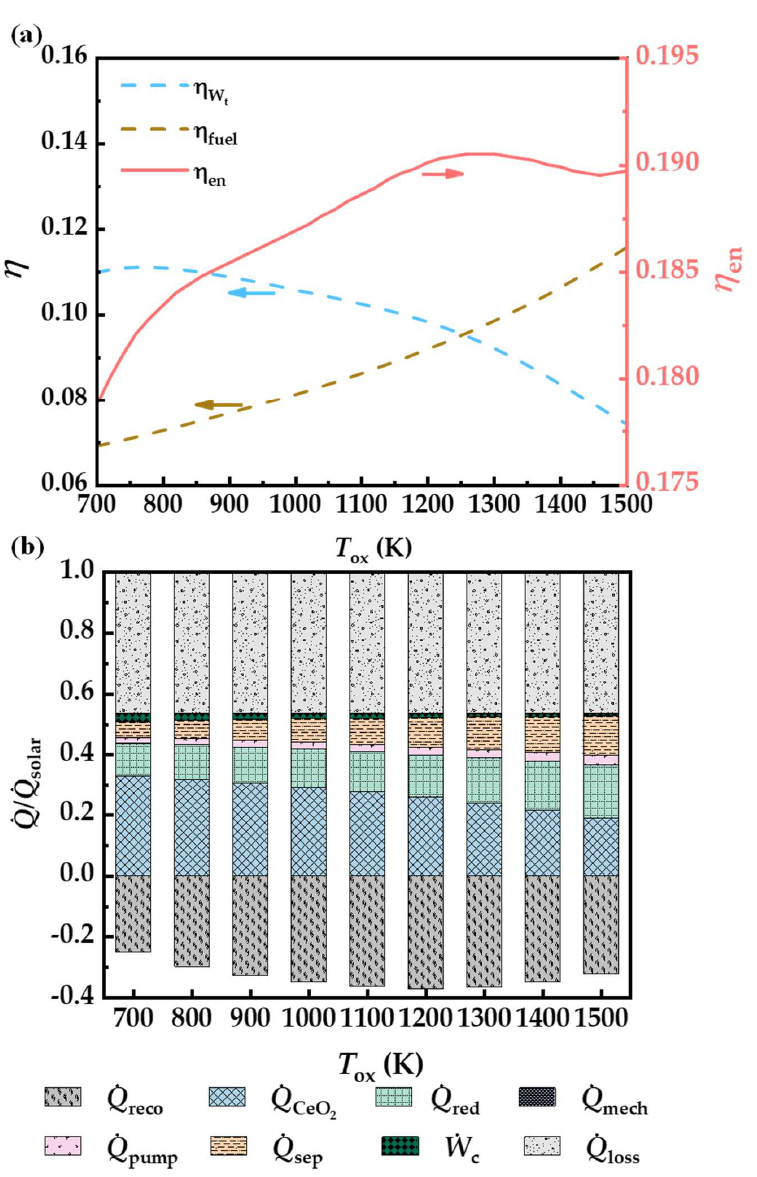
, and η en ( P red = 10 − 4 bar), ( b ) energy balance chart , h , and h ( P red = 10 −4 bar), ( b ) energy balance chart ( T red = Figure 5. ( a ) Effect of T ox on η fuel , η W t fuel en t W